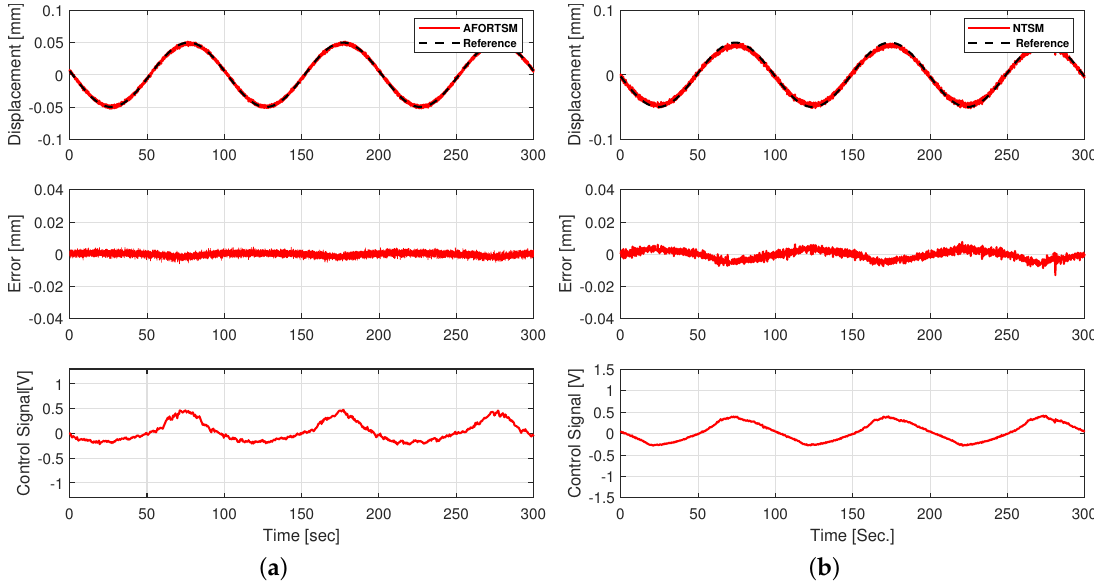
Figure 3. Test 2: Experimental results of AFORTSM and NTSM for tracking a single-tone sinusoidal reference without uncertainties (top: tracking profiles; middle: tracking error; bottom: control signal). ( a ) AFORTSM; ( b ) NTSM.